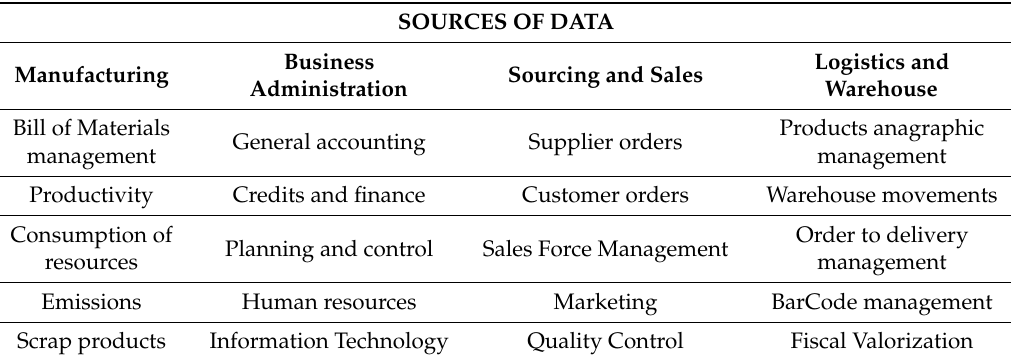
Table 1. Enterprise Resource Planning (ERP) data integration framework.